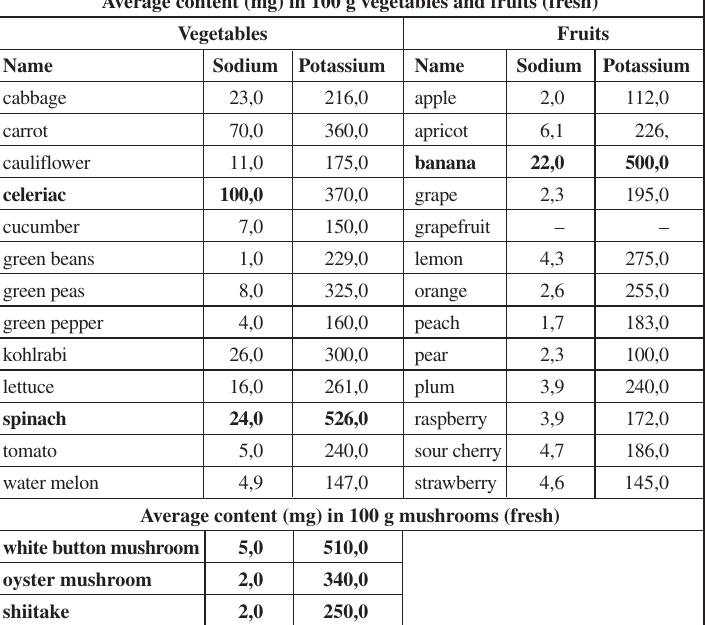
Table 2. Average sodium and potassium content (mg) in 100 g vegetables, fruits and mushrooms (fresh) Average content (mg) in 100 g vegetables and fruits (fresh) Vegetables